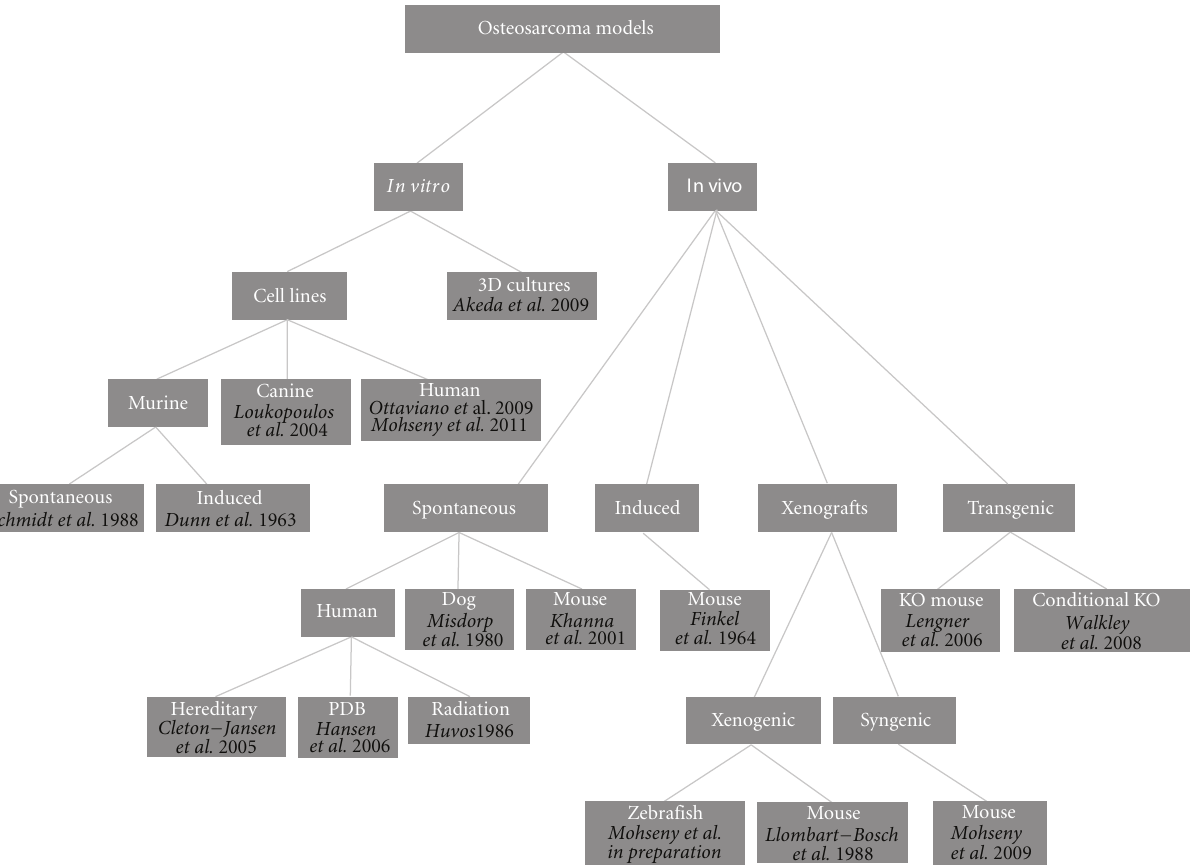
Figure 1: Osteosarcoma models. Dendrogram shows reported osteosarcoma models divided into categories. References are provided for each model.